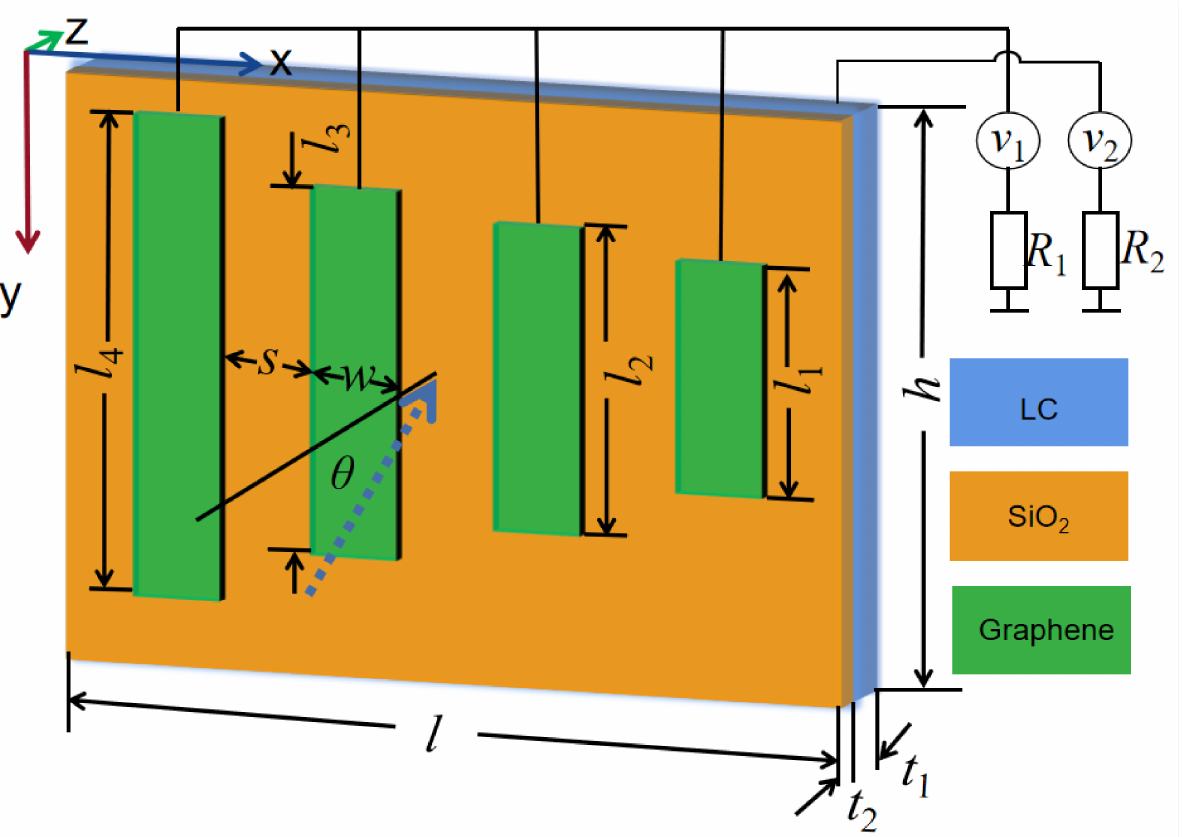
Figure 3. The schematic illustration of our proposed EIT